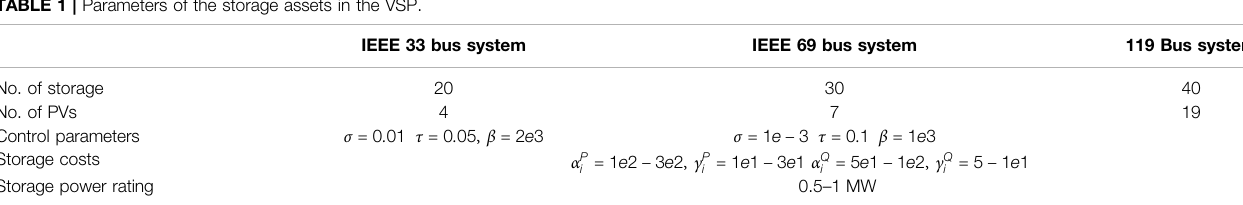
TABLE 1 | Parameters of the storage assets in the